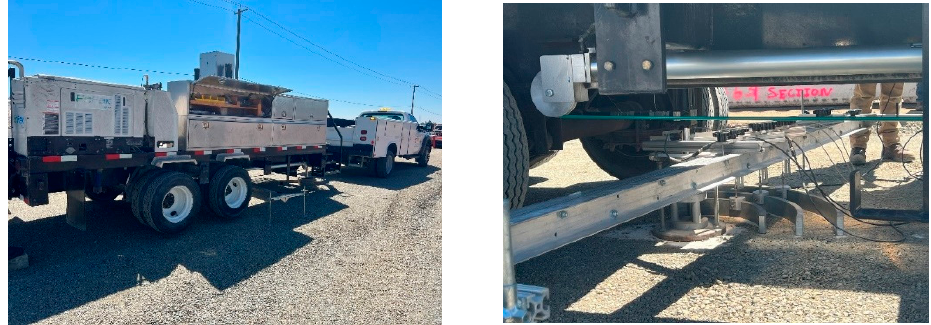
Figure 29. Automated plate load tests (APLT) used to determine in situ resilient modulus of aggre- gate layer.